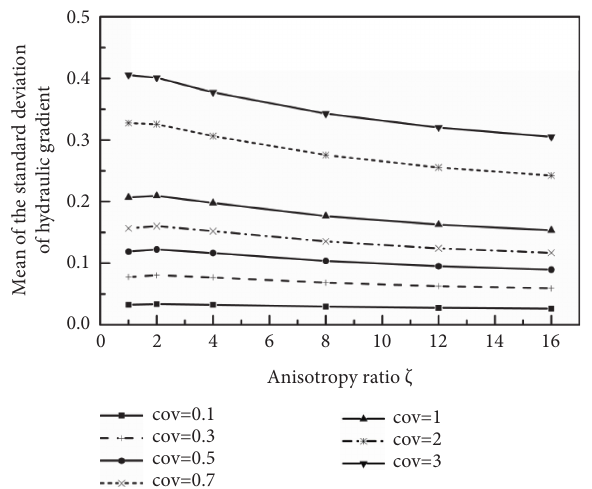
Figure 11: Mean of standard deviation of hydraulic gradient versus ζ of hydraulic